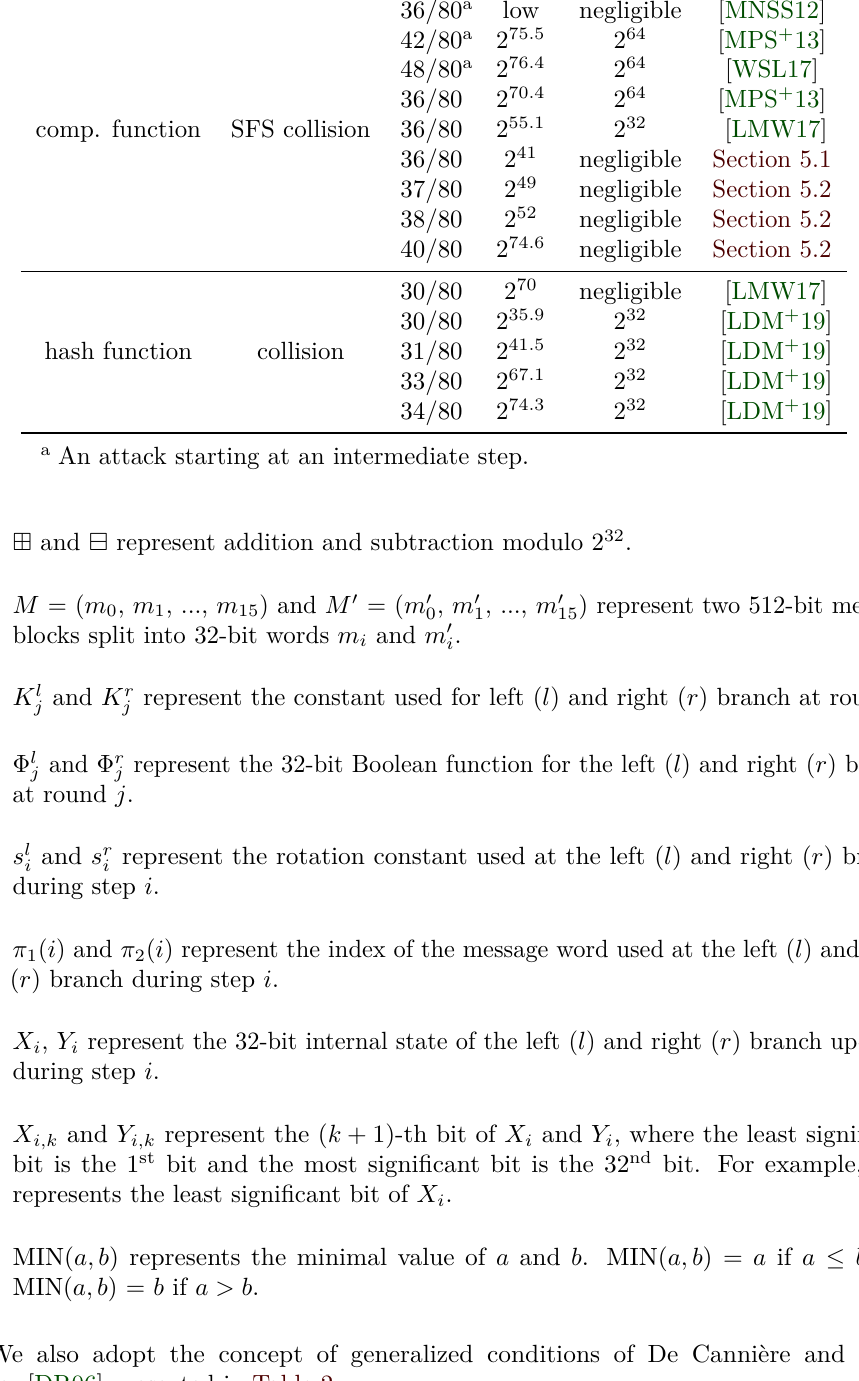
Table 1: Summary of preimage and collision attacks on reduced RIPEMD-160 Target Attack Type Steps Time Memory Ref. comp. function preimage 31 2 148 2 17 [OSS12] hash function preimage 31 2 155 2 17 [OSS12] 36/80 a low negligible [MNSS12] 42/80 a 2 75 . 5